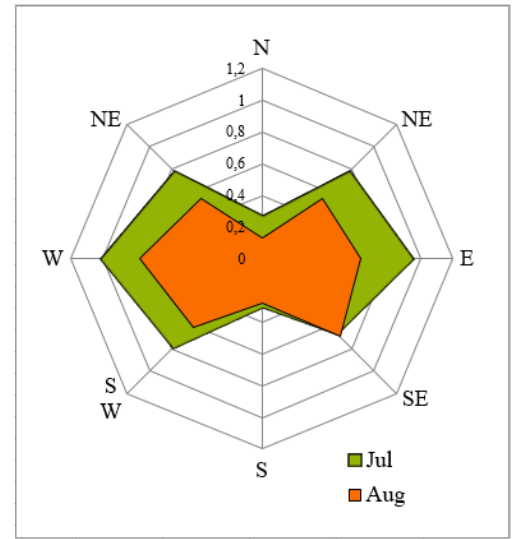
Figure 7. Variation of modelling results of averaged daily-